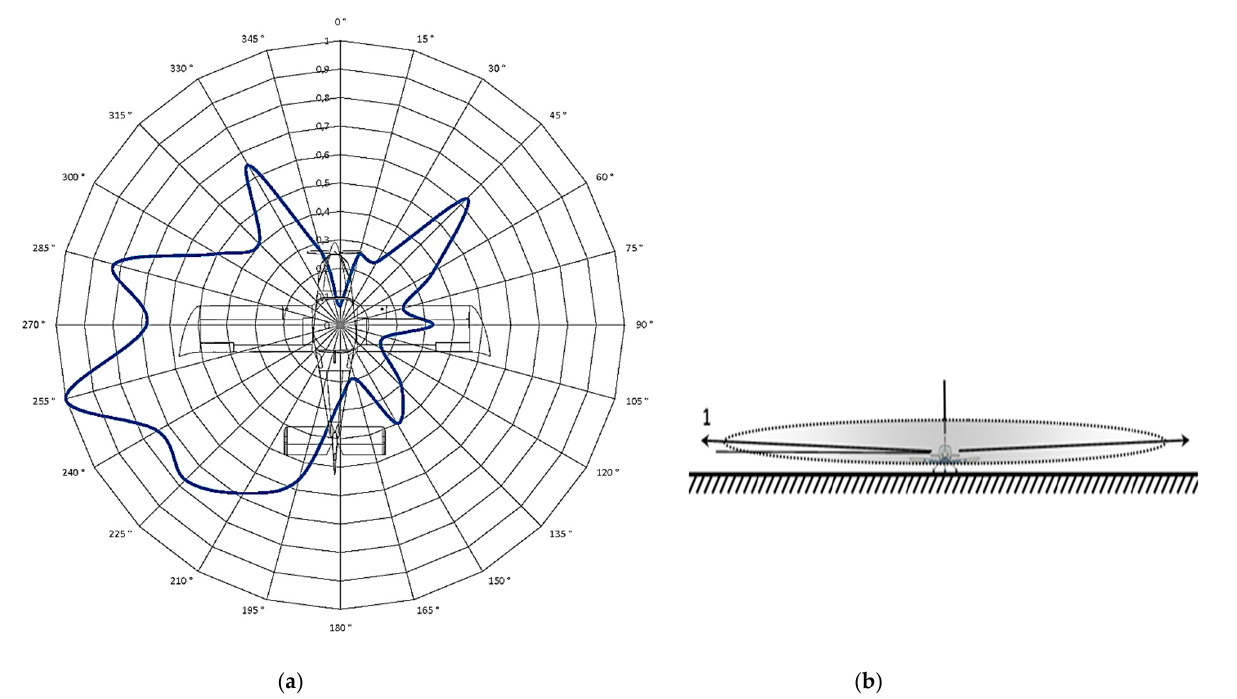
Figure 11. Measurement of the aircraft antenna characteristic at a position angle θ of 2°: ( a ) polar characteristics of the antenna; ( b ) spatial illustration of the measurement.